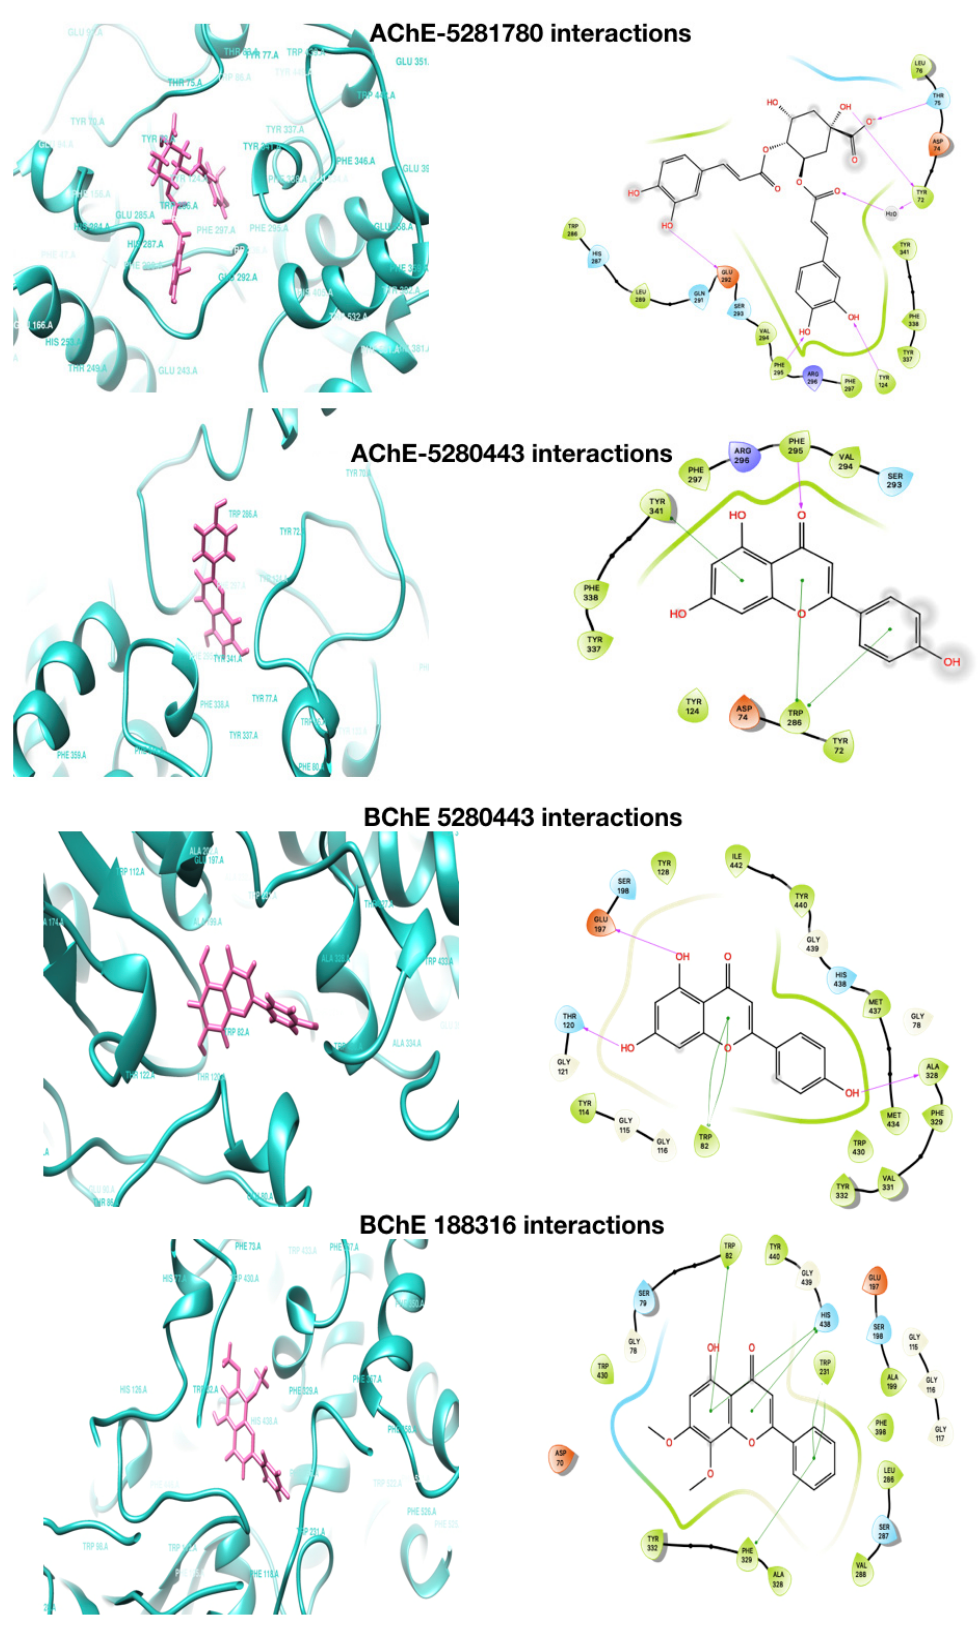
Figure 2. Molecular docking interaction of AChE and BChE with 5281780 , 5280443 , and 188316 . The third top compound 188316 was also found to have strong binding affinities with the proteins AChE and BChE, and moderate affinity with BACE-1. The docking and XP scores of 188316